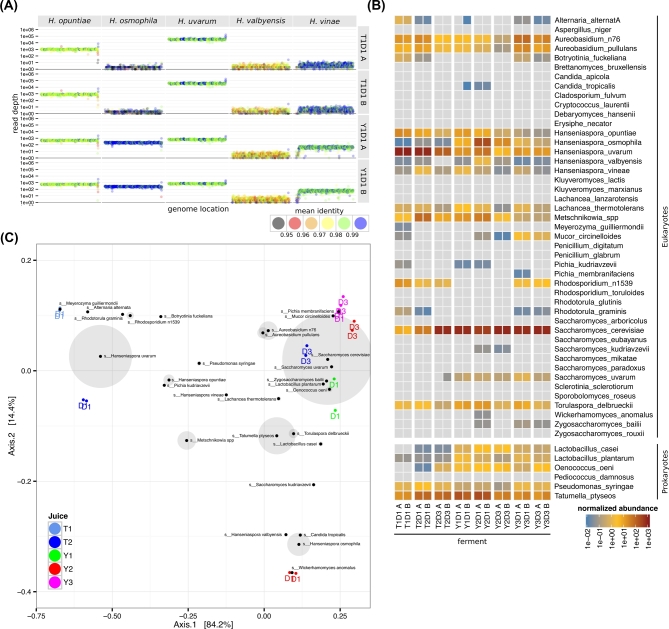
Shotgun metagenomic analysis of species. (A) Shotgun sequencing reads from each sample were mapped to the wine metagenome reference set. The total reads present in non-overlapping 10-kb windows across each genome were recorded relative to genomic location. In addition to total read number, the average identity of the reads in each window compared to the reference sequence was also calculated (id_factor). For clarity and space considerations, we depict here only the abundance measures for species within the Hanseniaspora genus for the 2 T2D1 and Y1D1 replicates (results for all samples are presented in Fig. S3). (B) Normalized average abundance values for each reference species in each sample. Values were normalized using total read numbers in each sample (including non-aligning reads), with final values represented per million reads in each 10-kb genomic window. (C) Bray-Curtis dissimilarity analysis of the shotgun abundance data. The weightings of each reference genome are overlaid on the plot, with the size of the gray circles around each node proportional to the total abundance of each reference genome across all of the samples (no shading for nodes >10).